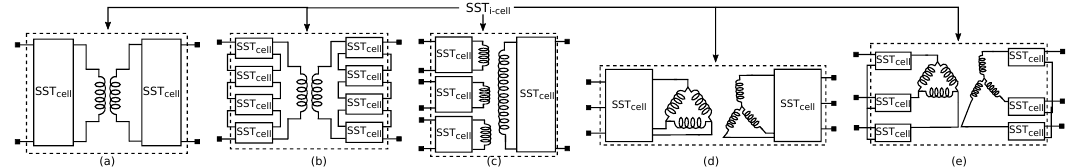
Figure 9. Different types of SST i-cell [32]: ( a ) SST i-cell formed using single phase transformer and single SST cell , ( b ) SST i-cell formed using single phase transformer and multiple SST cell , ( c ) SST i-cell for multi-winding transformer, ( d ) SST i-cell using three phase transformer and three phase SST cell , and ( e ) SST i-cell formed using a three phase transformer and multiple single phase SST cell